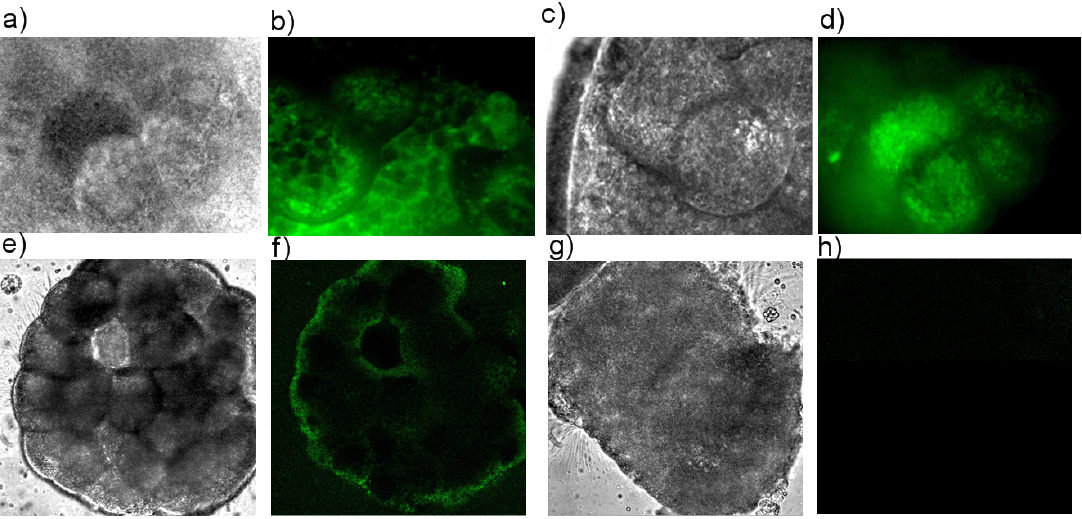
Figure 1: Images of GH-GFP expression in abalone larvae 48 h after fertilization with electropored sperm; a) - b), c) - d), e) - f), the same larvae without fluorescence excitation and with fluorescence excitation. g) - h) control negative embryos, without and with fluorescence excitation,